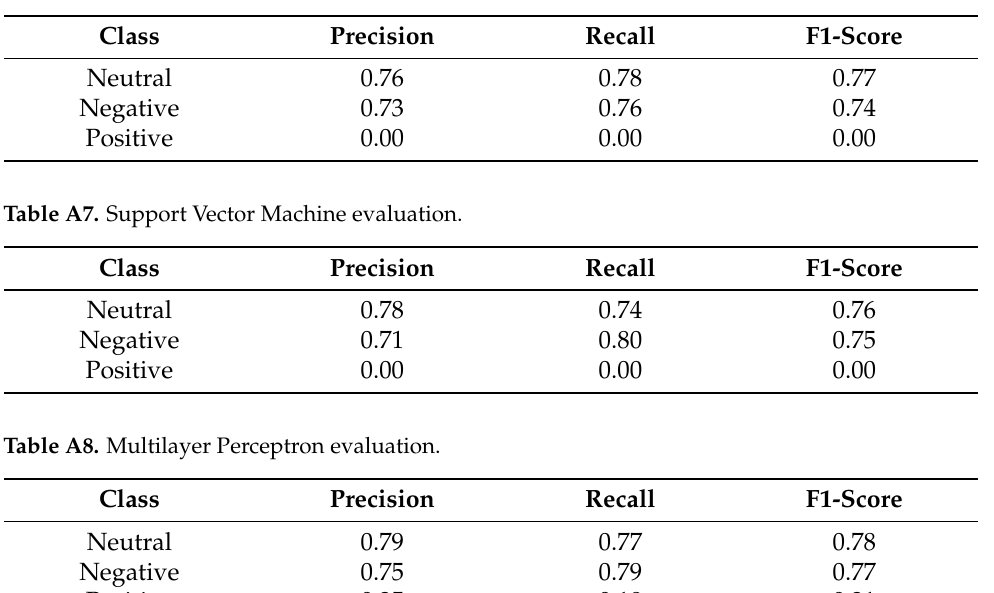
Table A6. Random Forest evaluation.